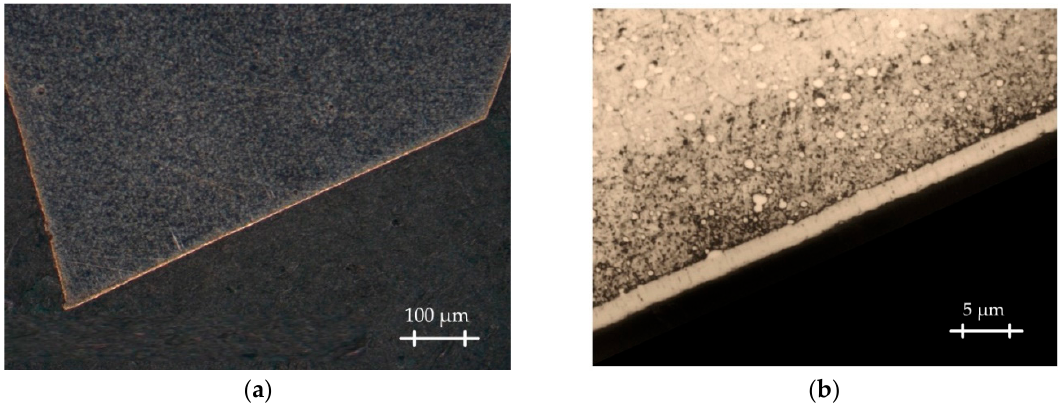
Figure 8. Optical images of a high-speed steel reamer after combined surface strengthening: ( a ) a general view of a reamer tooth; ( b ) microstructure of the surface layer of the reamer tooth.